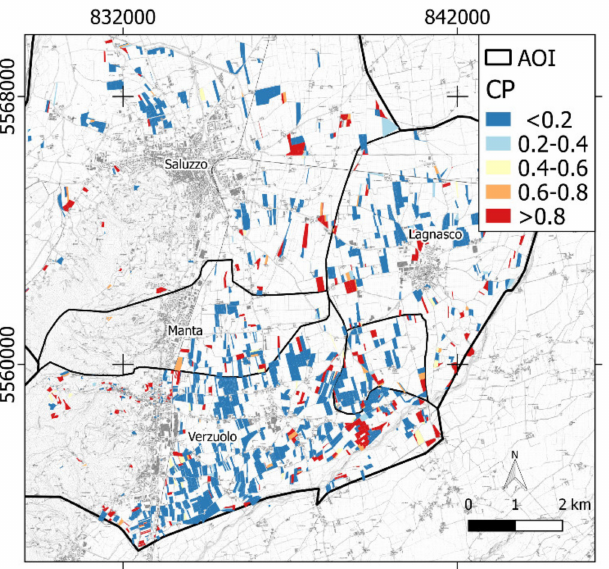
Figure 6. A CP map of apple orchards in the AOI (Reference frame: WGS84 UTM32N).